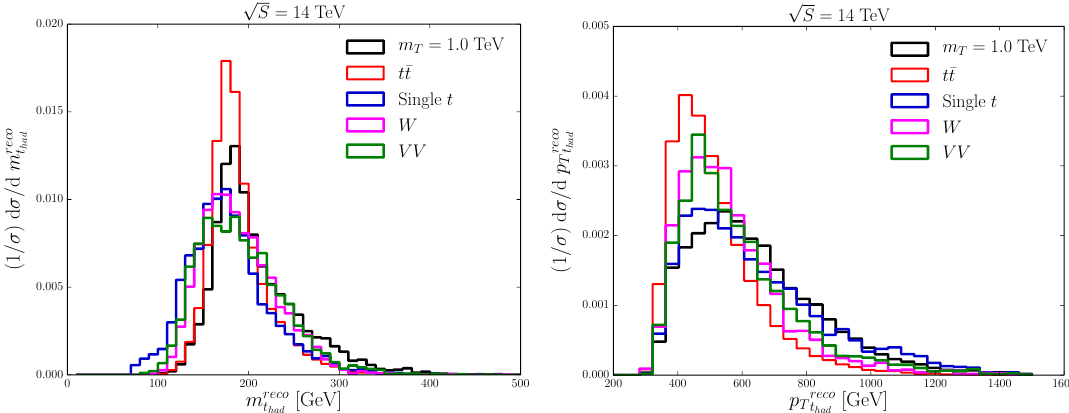
Figure 3 . The reconstructed invariant mass distribution of the top-tagged fat jet (left) and the corresponding p T distribution (right) in the ttgg channel for m T = 1 : 0 TeV.